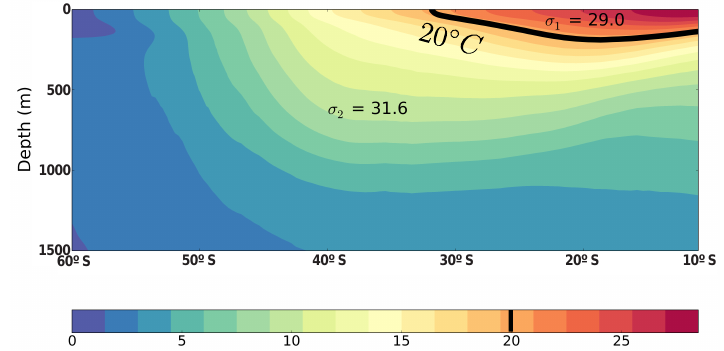
Figure 2. Meridional section of temperature ( ◦ C) at 80 ◦ E from Argo floats (ARIVO project; Gaillard and Charraudeau, 2008). The 20 ◦ C isotherm is used to divide the basin into an upper and lower layer. For both layers, average relative densities σ are denoted, which are used for defining the stratification of the two-layer model. The isotherm shows outcrop near 30 ◦ S, marking the southern boundary of the upper layer.